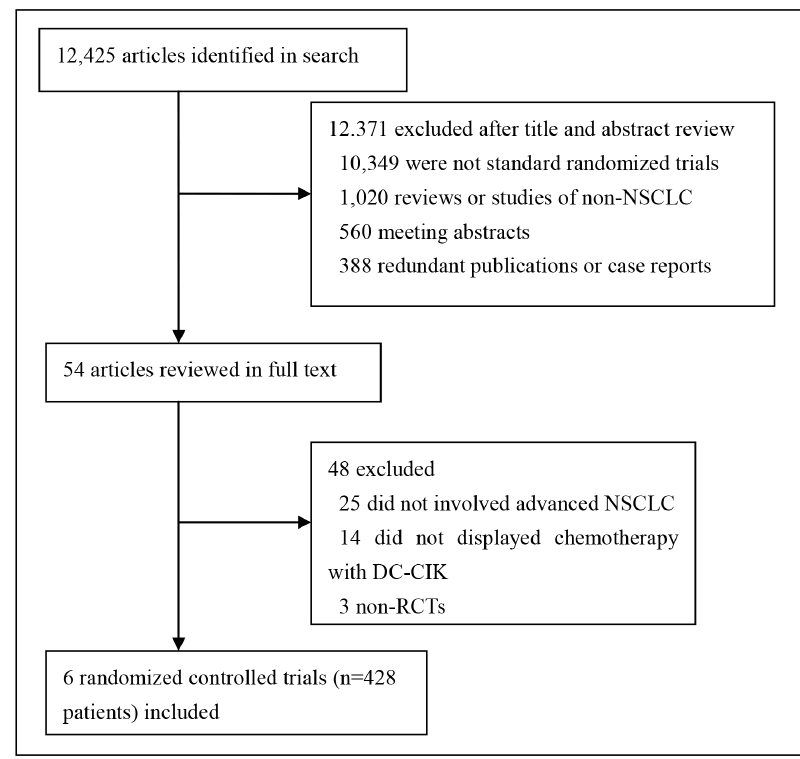
Figure 1. Flow diagram.